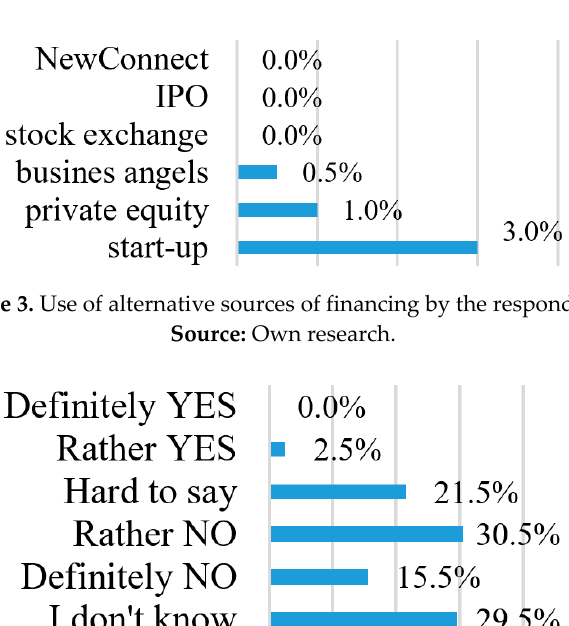
Figure 2. Recognition of financial instruments among the respondents. Source: Own research.